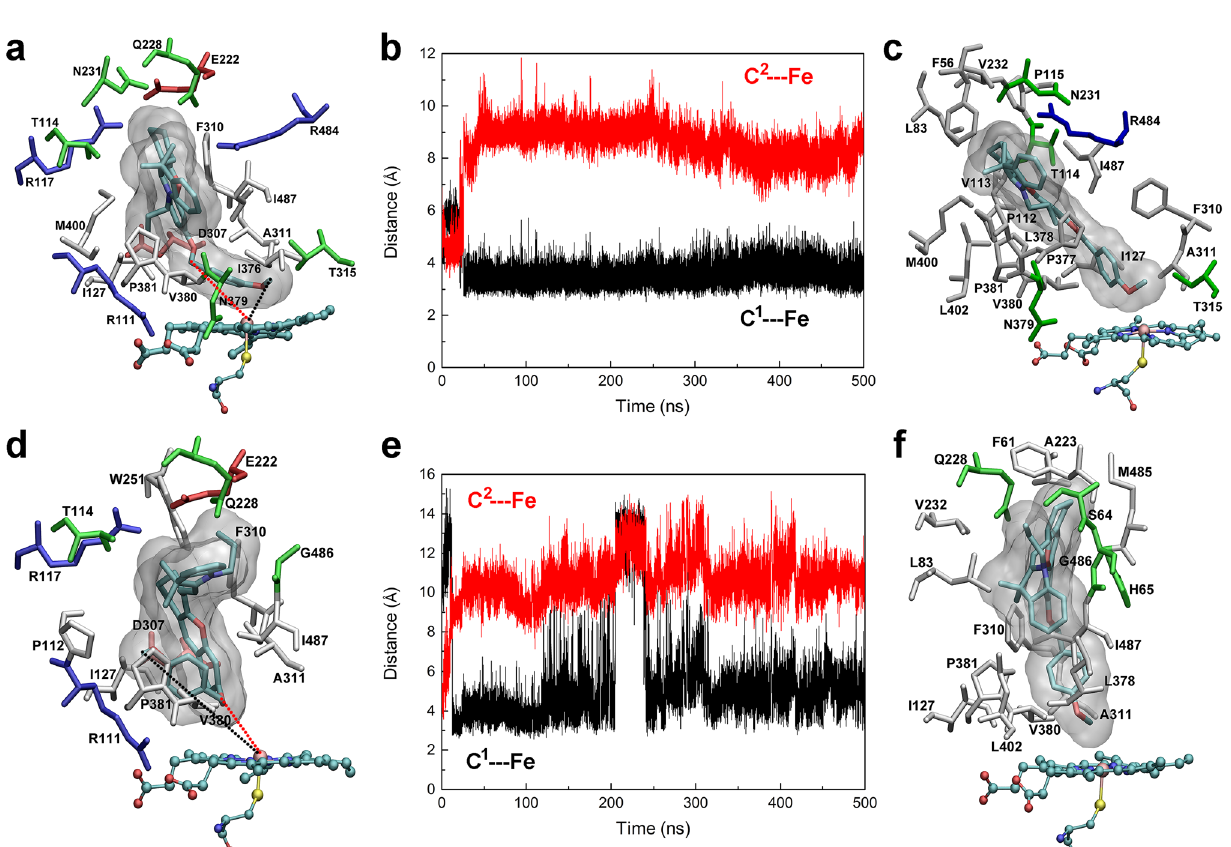
Figure 4. MD simulations of CYP2J2 in complex with M2 in the extended ( a – c ) or folded conformation ( d – f ). ( a , d ) The initial binding pose of M2 in the active site of CYP2J2; ( b , e ) The distance between the proposed metabolic site (C 1 atom) and the heme iron during the simulations. For comparison, the distance between another C 2 atom and the heme iron was also monitored; and ( c , f ) The representative binding conformation of M2 in the active site of CYP2J2. This figure was rendered using VMD 27 (http://www.ks.uiuc.edu/Resea rch/